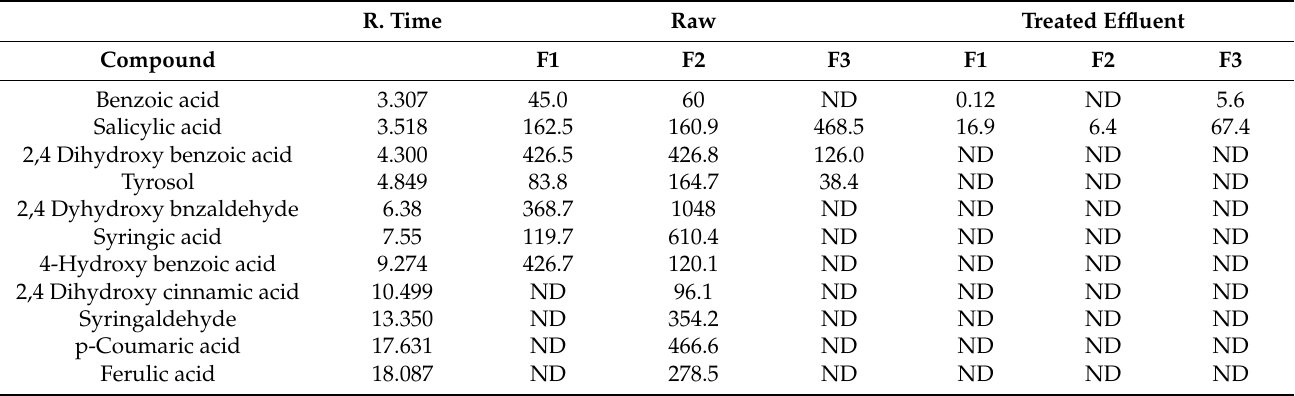
Table 4. The concentration of the polyphenolic compounds for both raw and treated OMW Adapted from Reference [55]. R. Time